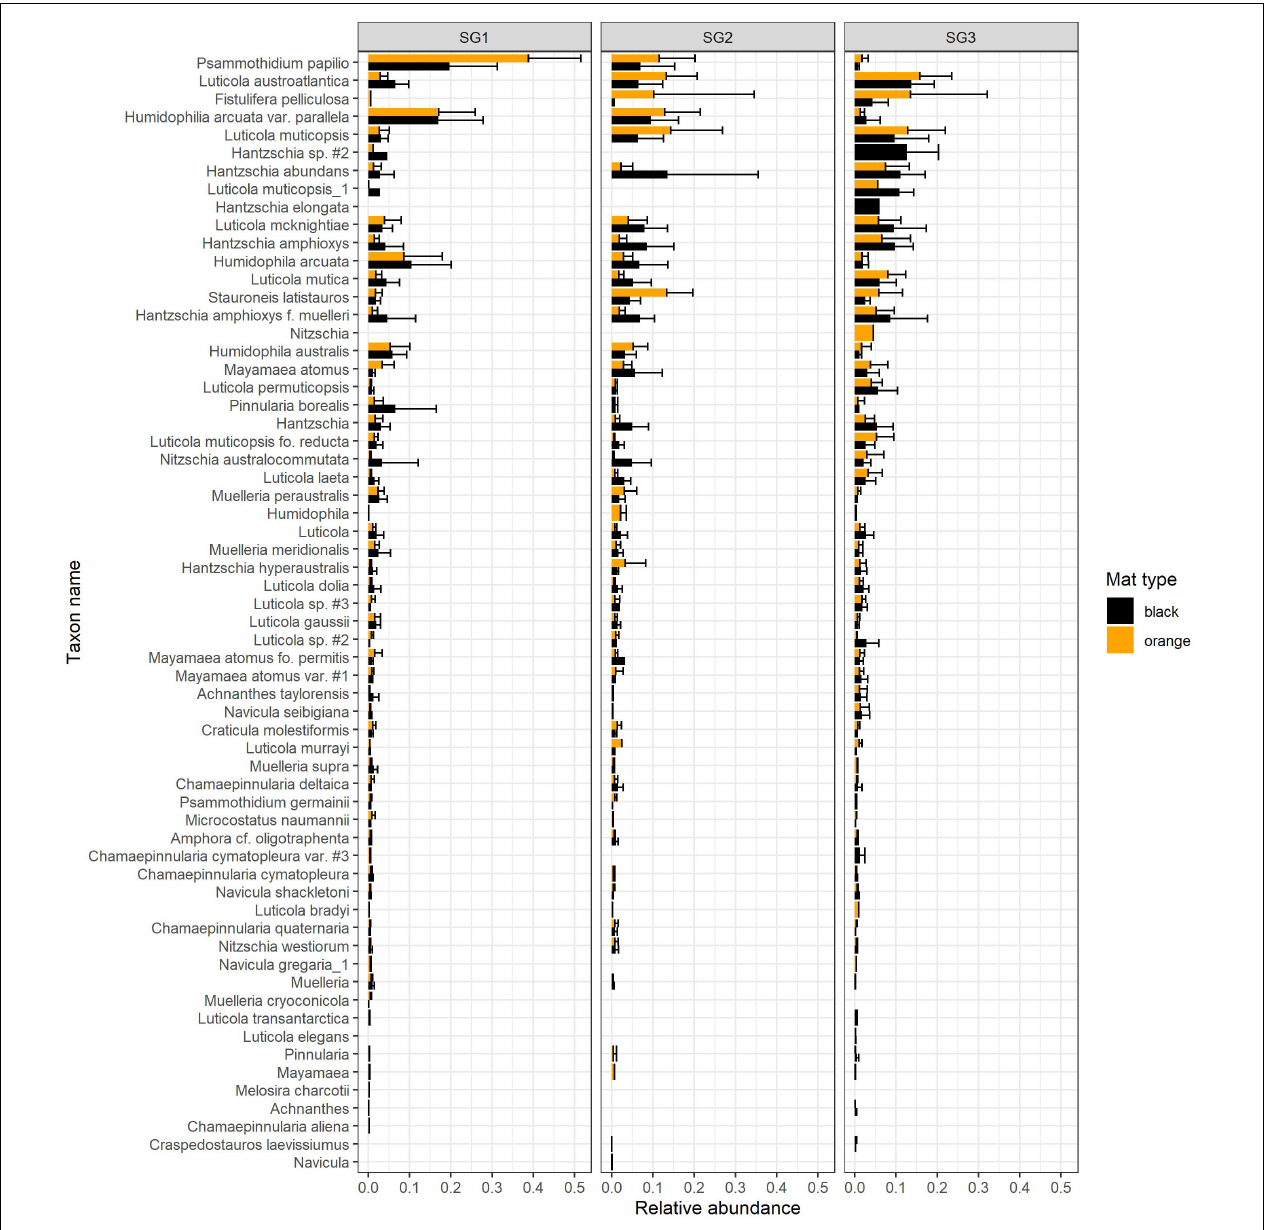
FIGURE 3 | Summary of relative abundances (mean ± sd) of diatom taxa in the MCM LTER record for samples collected from orange and black cyanobacterial mats for each “stream group”. Morphospecies designations in the source database were